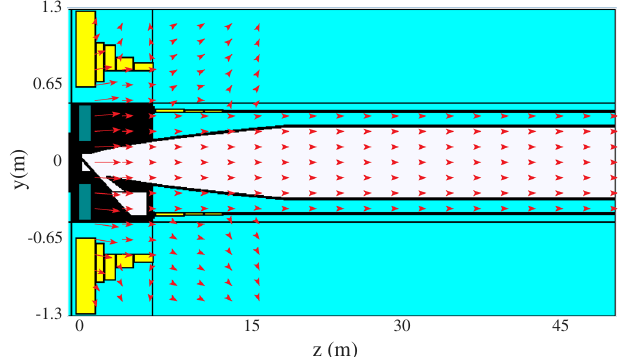
FIG. 1. MARS model of the NF/MC front-end channel. The yellow blocks represent the superconducting solenoid coils while the dark-blue ones are for the normal conducting coils of the 20-T hybrid solenoid. The red arrows indicate the strength and direction on the magnetic field. The black area represents the mercury jet target system with its